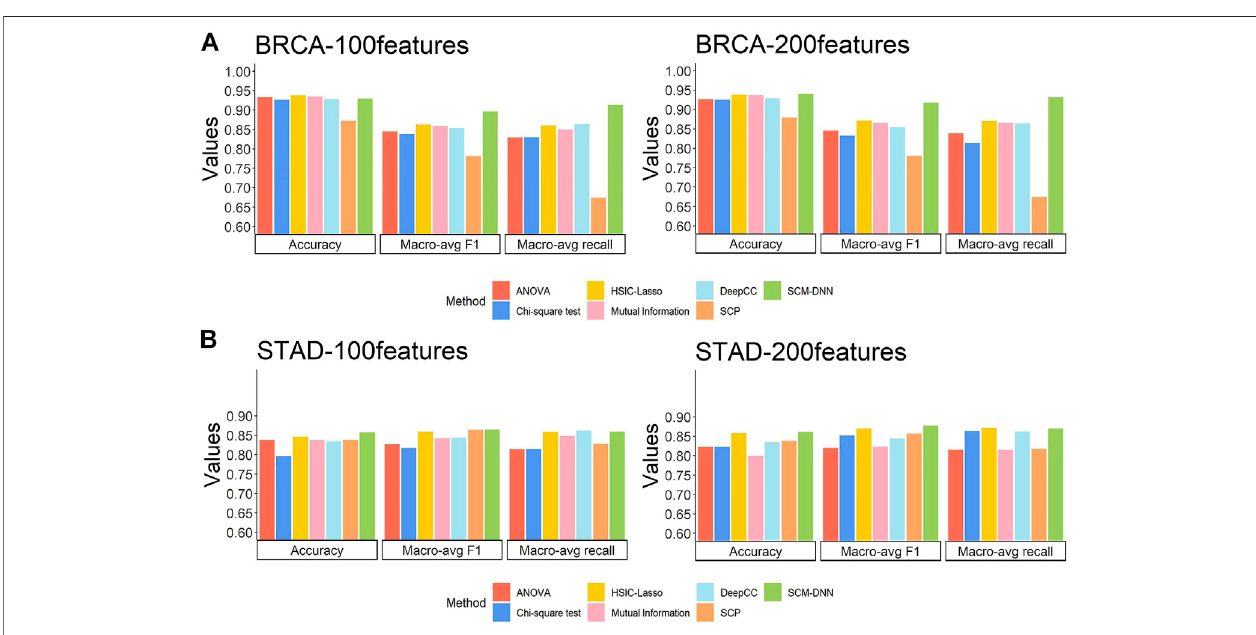
FIGURE3 | Cancer subtyping performance byseven methods: ourmethodSCM-DNN,HSIC-LASSO, ANOVA, Chi-square mutual information, SCP and DeepCC (A) BRCA subtyping and (B) STAD subtyping with using top100 and 200 distinguishing co-expressed gene pairs.